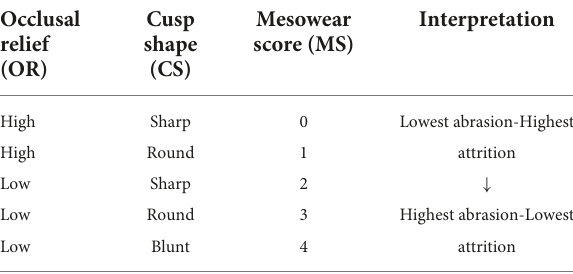
TABLE 2 Interpretations of mesowear scores following Kaiser et al.